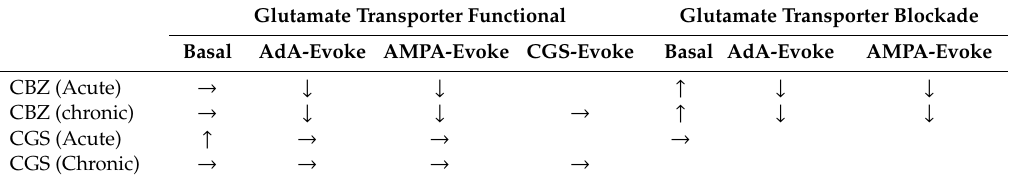
Table 1. E ff ects of CBZ and CGS21680 on Astroglial L-Glutamate Release.